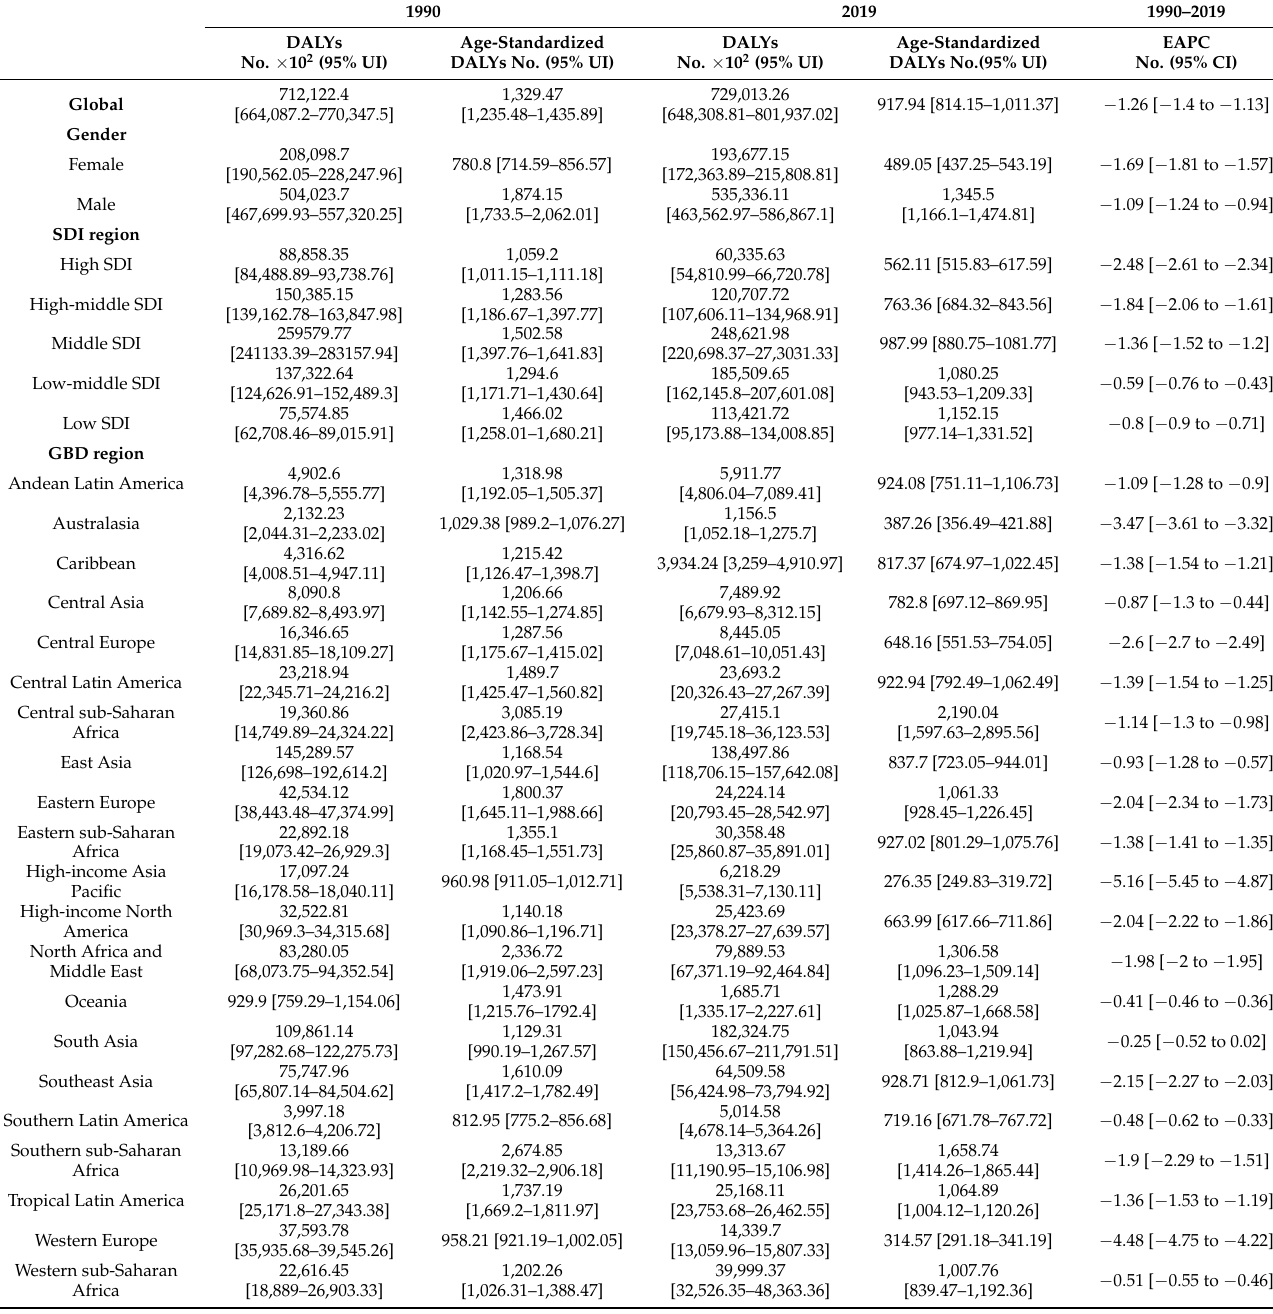
Table 3. DALYs, AS-DALYs, and temporal trends of RIs in 1990 and